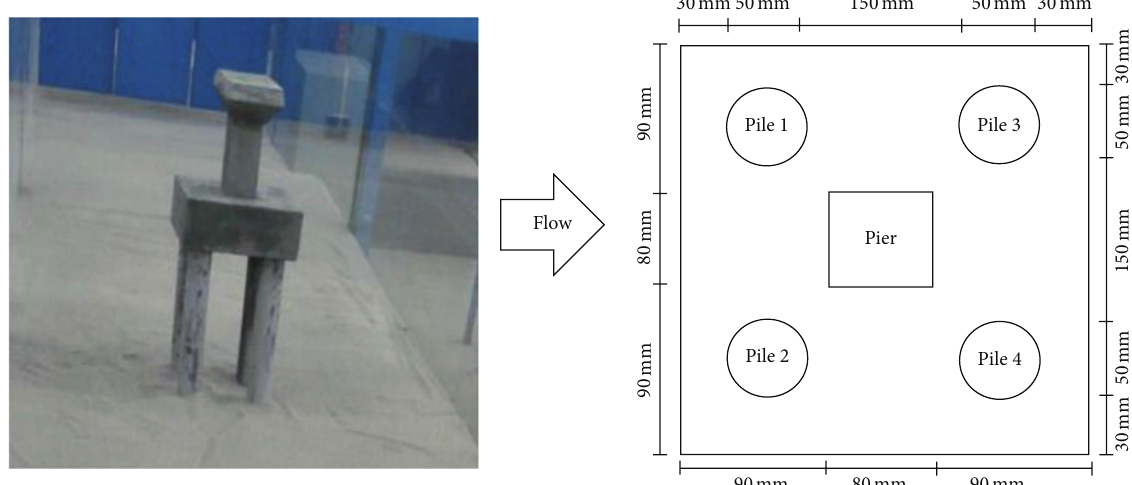
Figure 2: Bridge piers model in laboratory.